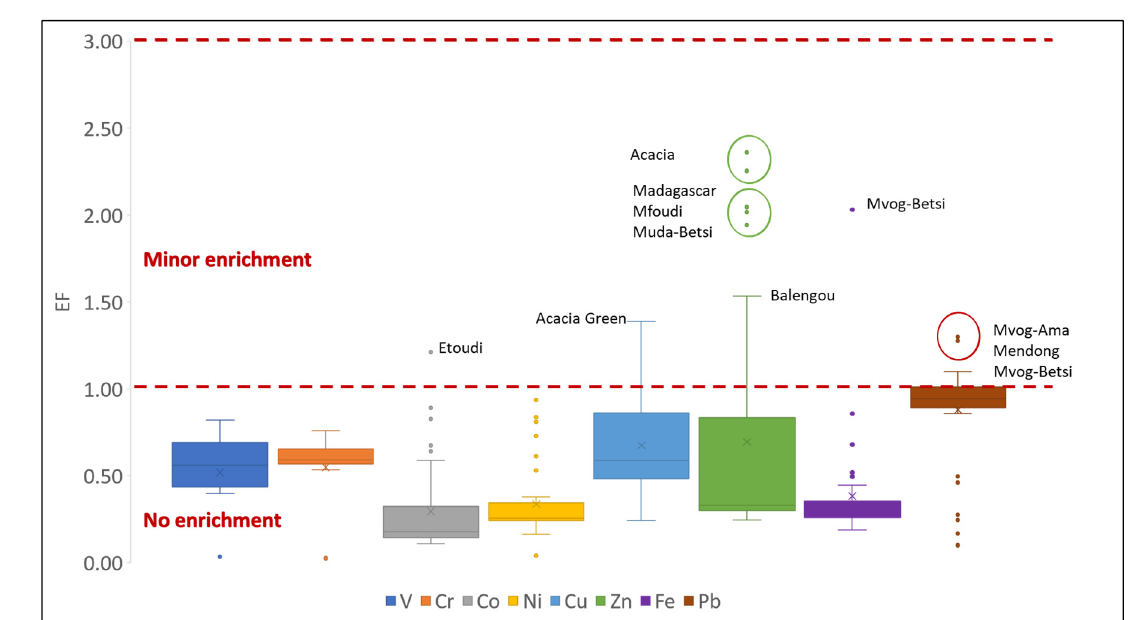
Figure 12. Enrichment factor of selected metals in studied geophagic clays.